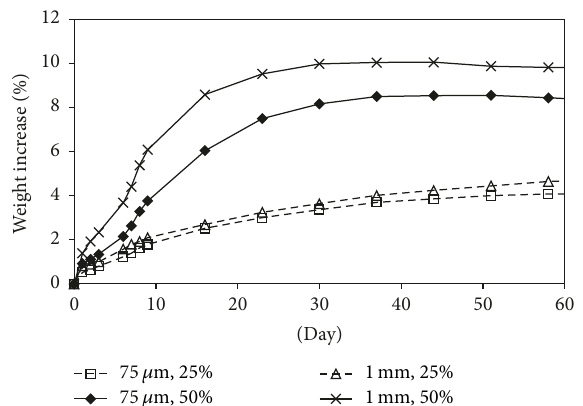
Figure 2: Long-term (60 days) water uptake of PVC/bamboo composites (C 1 ) using different bamboo particle sizes and loading [17].